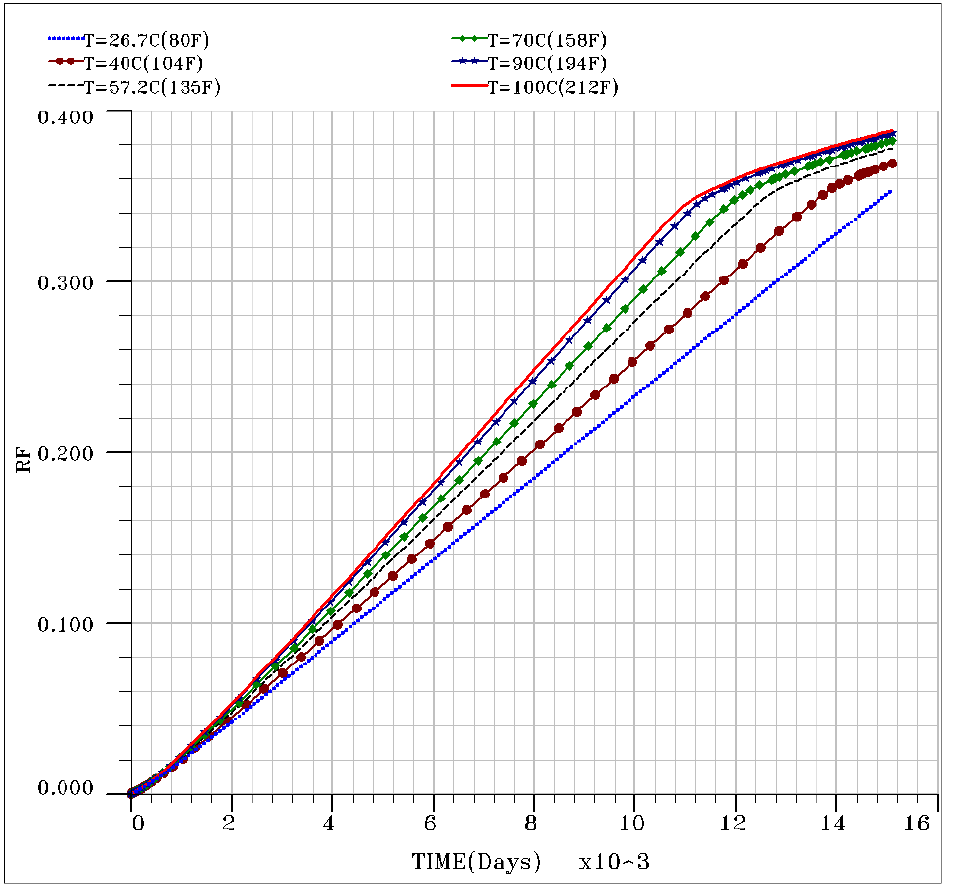
Figure 1. Simulated oil recovery factor (RF) of injecting water at different temperature from 26.7 (cid:176) C (80 (cid:176) F) to 100 (cid:176) C (212 (cid:176) F). Room temperature relative permeability data are used in this case. Reservoir Temperature is taken to be 57.2 (cid:176) C (135°F). The higher the temperature of the injected water, the higher recovery factor